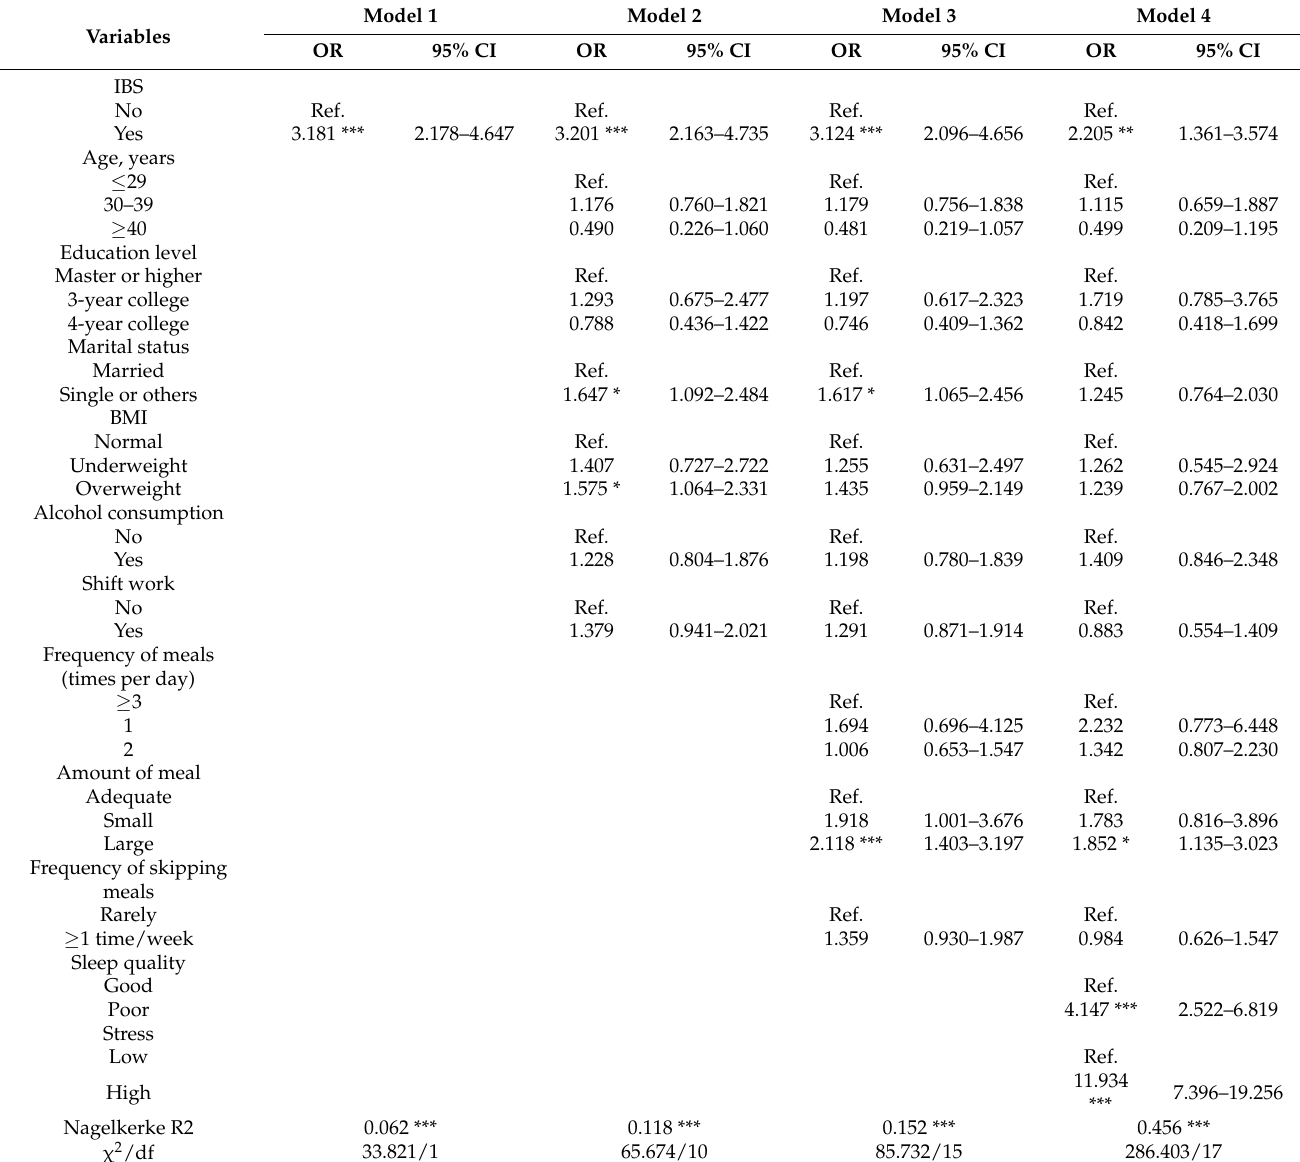
Table 4. Effect of irritable bowel syndrome on depressive symptoms (N =